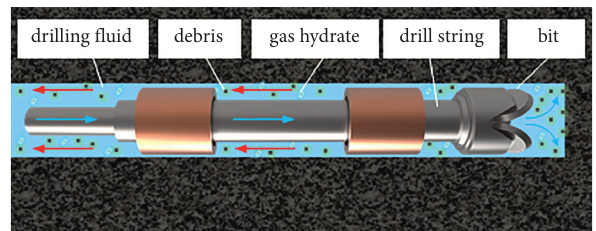
Figure 1: Working environment of the drill